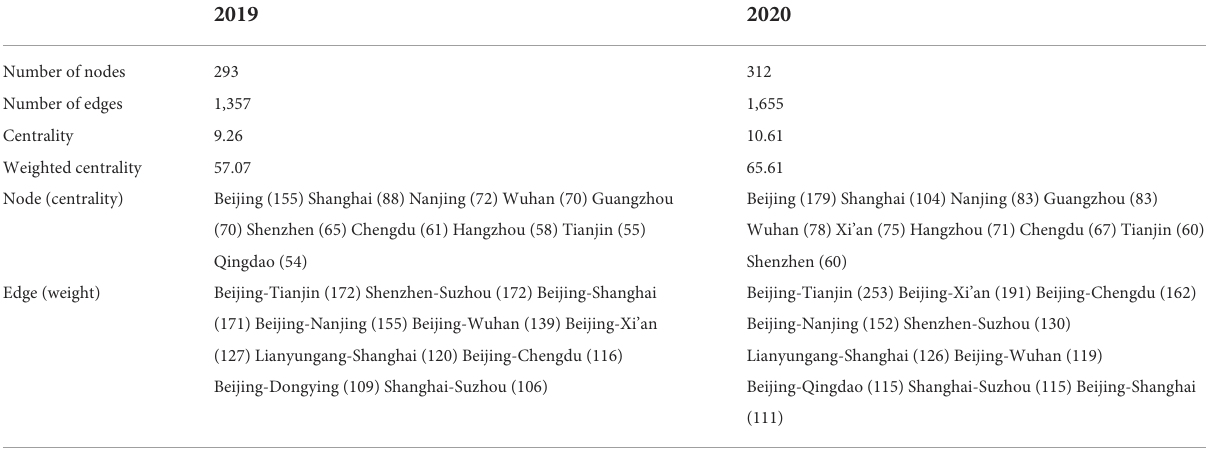
TABLE 2 Evolution of statistical characteristics and network patterns of the Chinese national urban biomedicine innovation